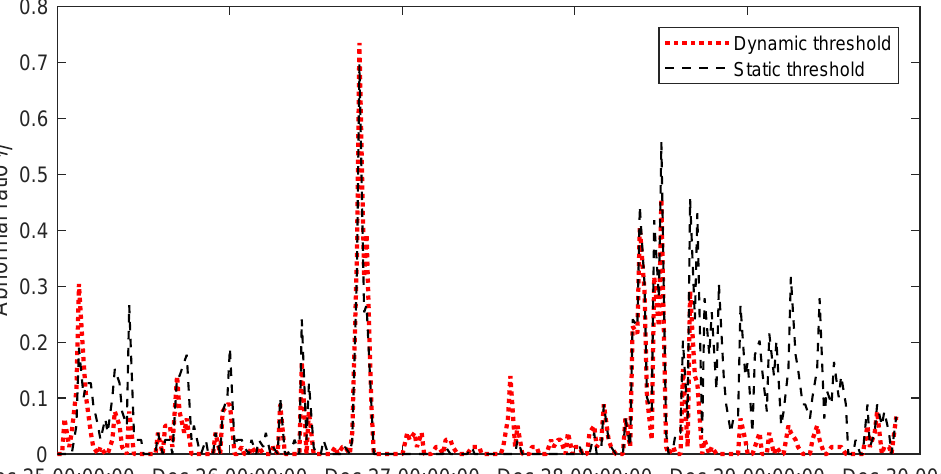
Figure 15. Comparative motoring results for testing residuals under dynamic thresholds and static thresholds.